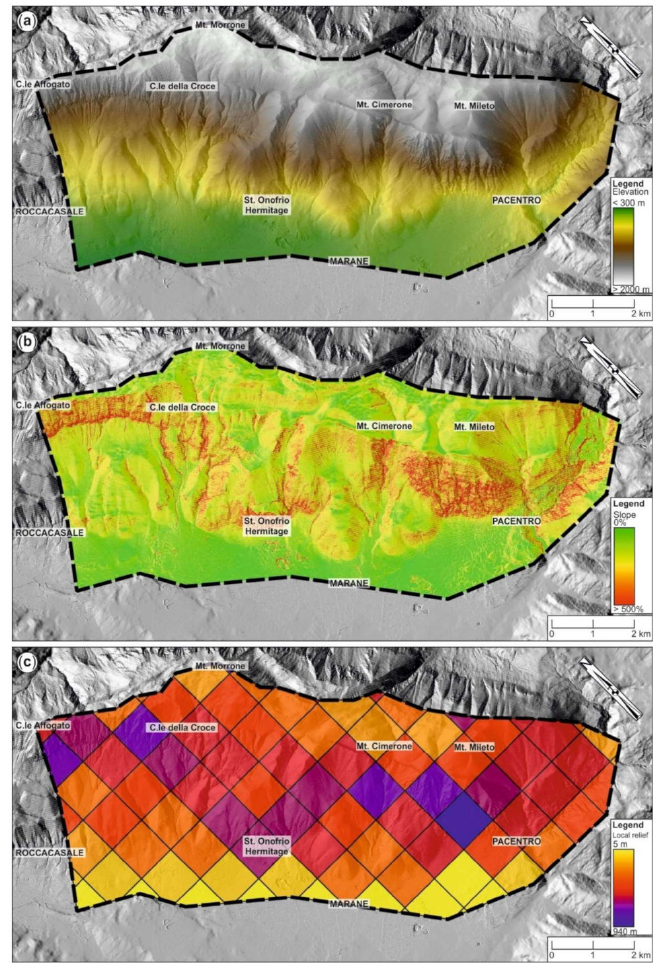
Figure 7. Physiographic features of the study area: ( a ) elevation map; ( b ) slope map; ( c ) local relief map. The dashed black line shows the study